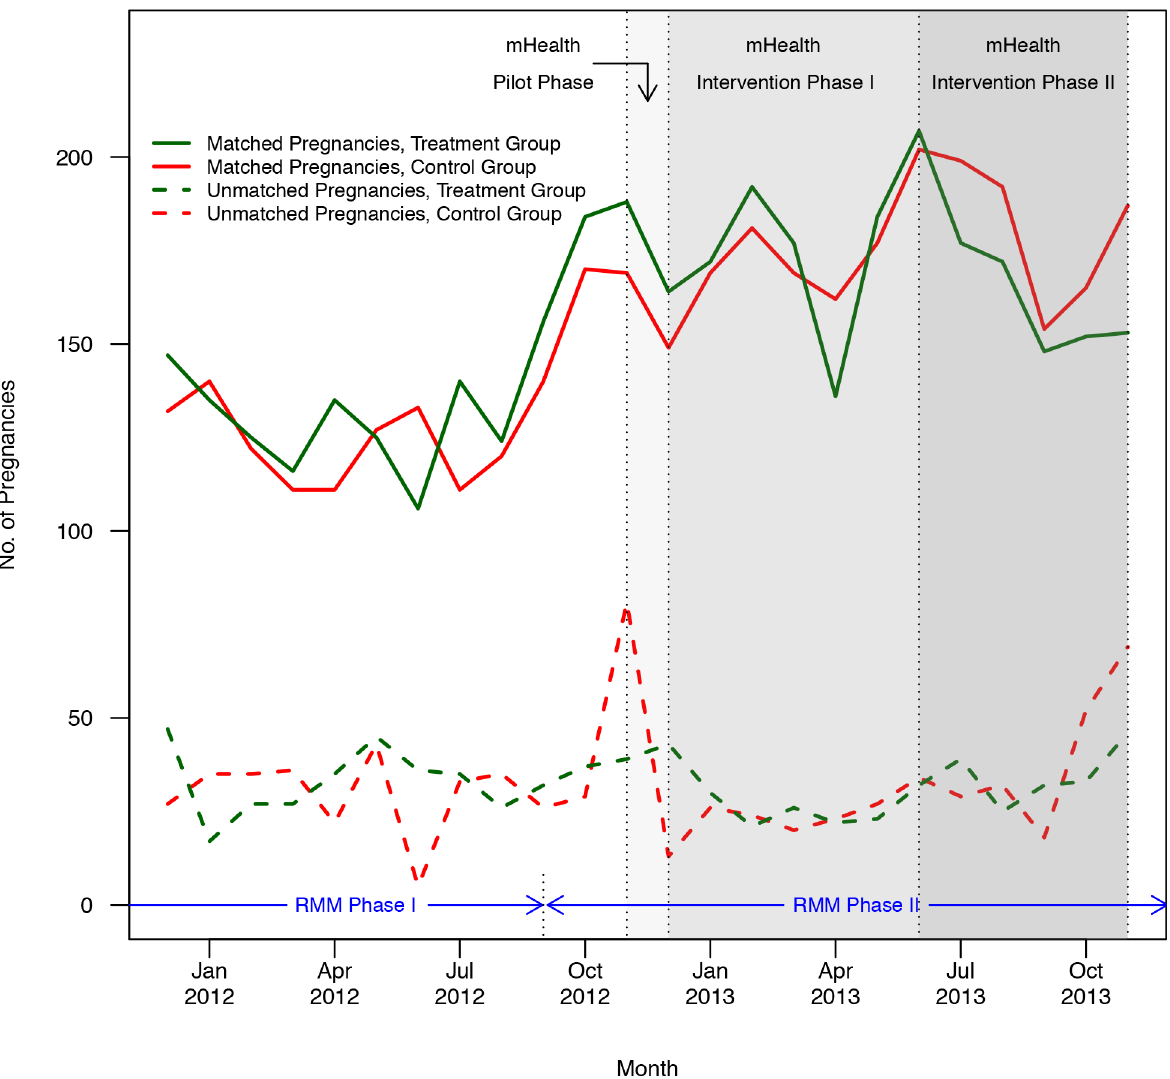
Fig 3. Matched and unmatched pregnancies by group. Number of matched and unmatched pregnancies by group during SMS baseline and intervention periods from December 2011 through November